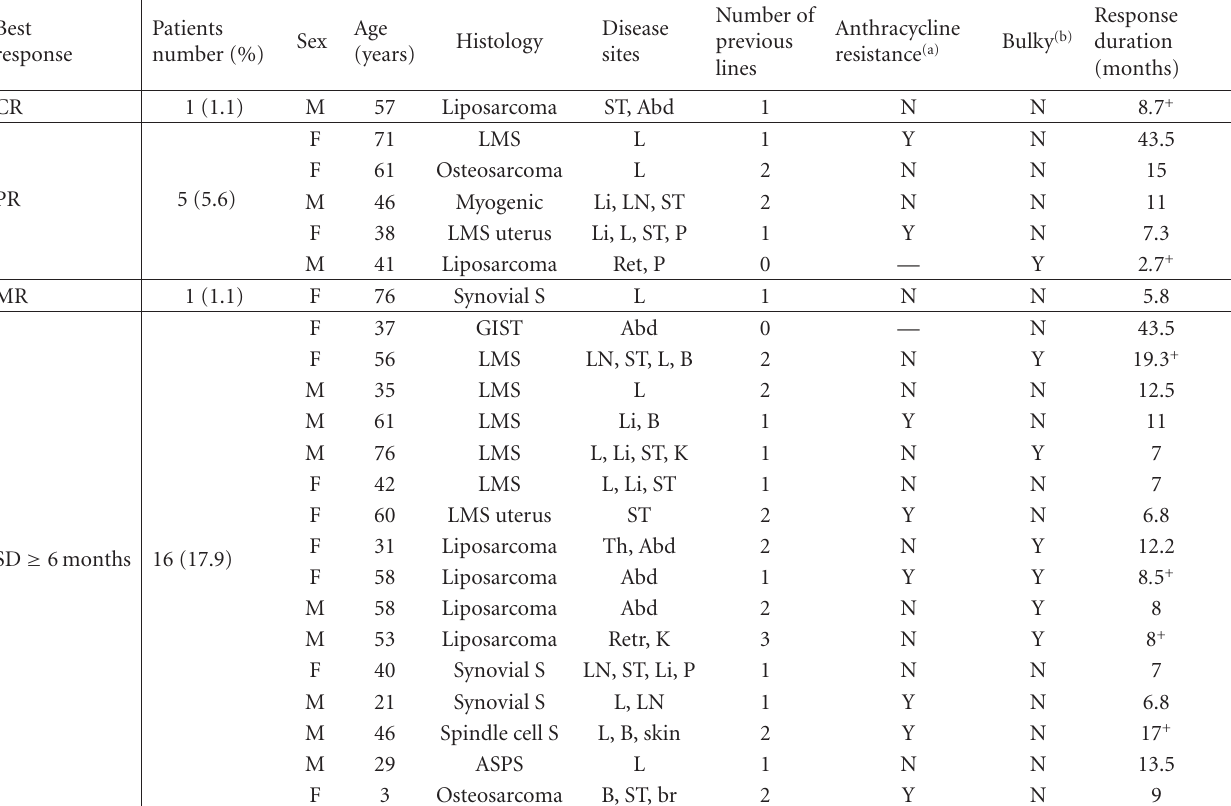
Table 4: Characteristics of responding patients. CR: complete remission; PR: partial remission; MR: minor response; SD: stable disease; M: male; F: female; LMS: leiomyosarcoma; S: sarcoma; GIST: gastrointestinal stromacell sarcoma; ASPS: alveolar soft part sarcoma; ST: soft tissue; Abd: abdominal; L: lung/pleura; Li: liver; Ret: retroperitoneal; P: peritoneal; LN: lymph nodes; Th: thyroid; K: kidney; B: bone; br: